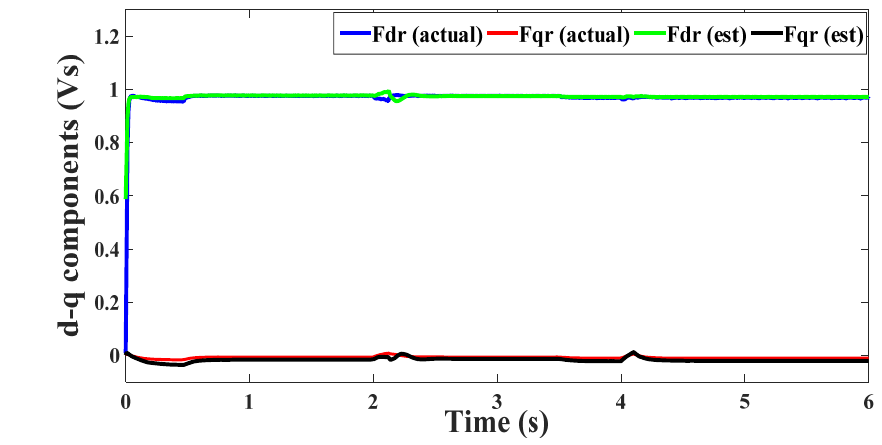
Figure 24. Estimated and actual rotor flux d - q components.